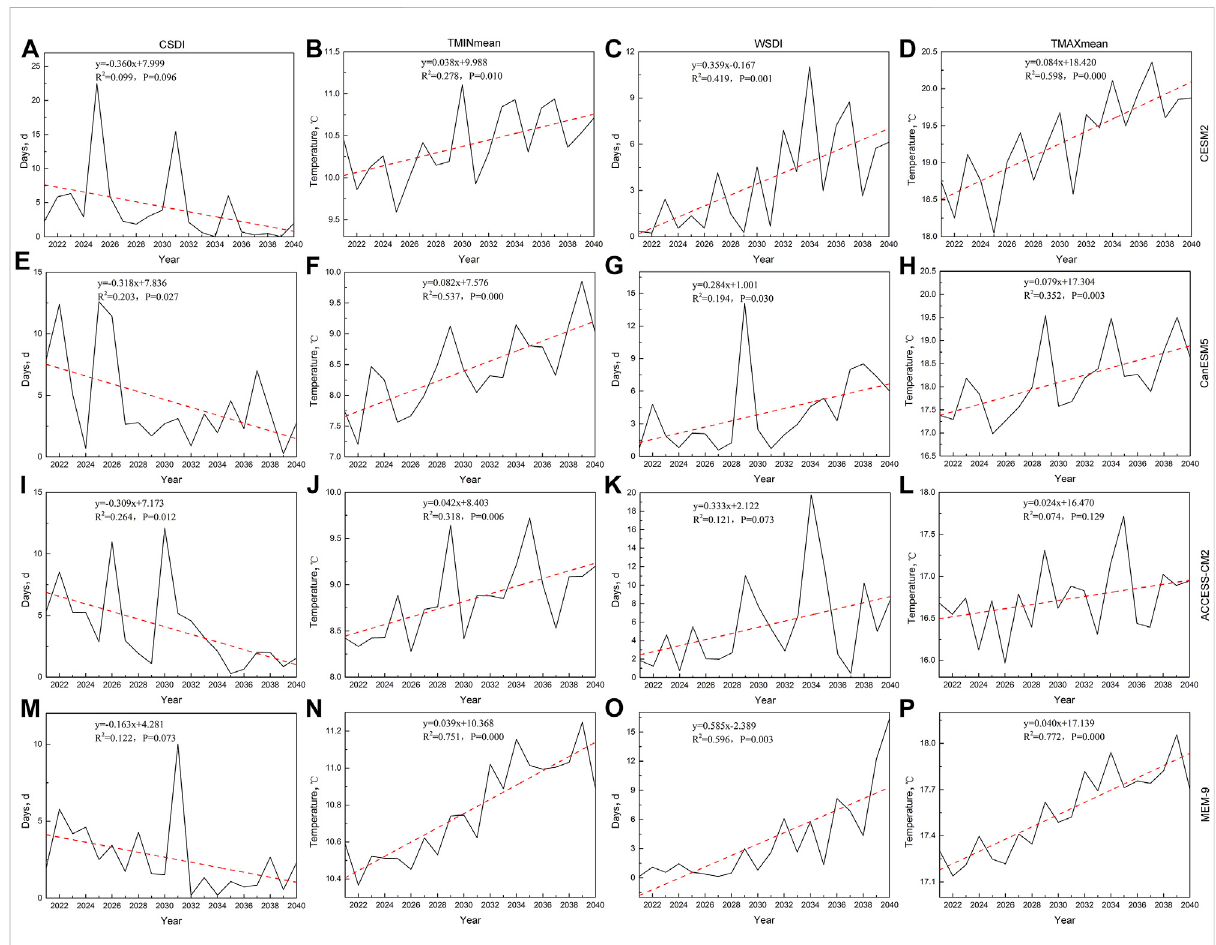
FIGURE 3 Projections of the temporal change trends of the 4 ETIs in the next 20 years by different models under the SSP2-4.5 scenario. CESM2 [ (A) CSDI (B) TMINmean (C) WSDI (D) TMAXmean], CanESM5 [ (E) CSDI (F) TMINmean (G) WSDI (H) TMAXmean], ACCESS-CM2 [ (I) CSDI (J) TMINmean (K)